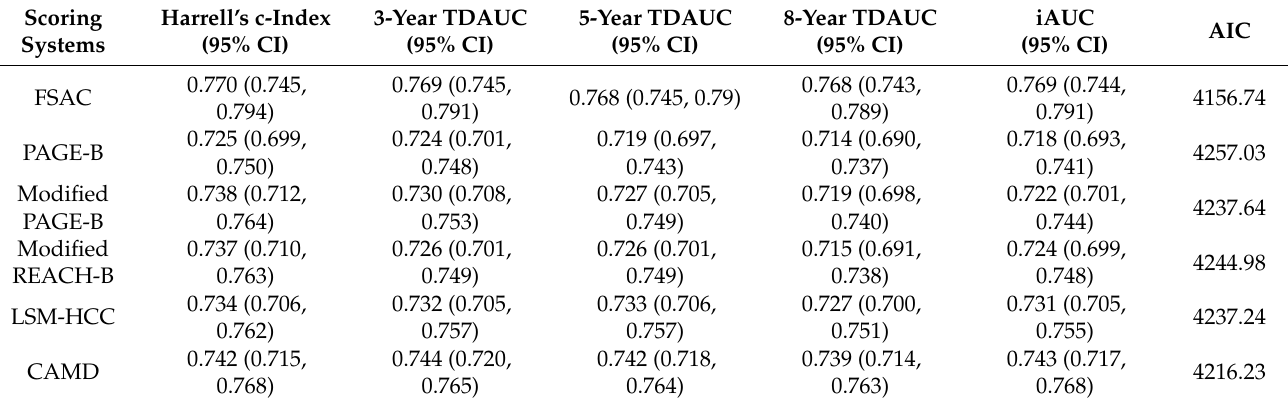
Table 3. Predictive performance of the FSAC and other risk-prediction models.